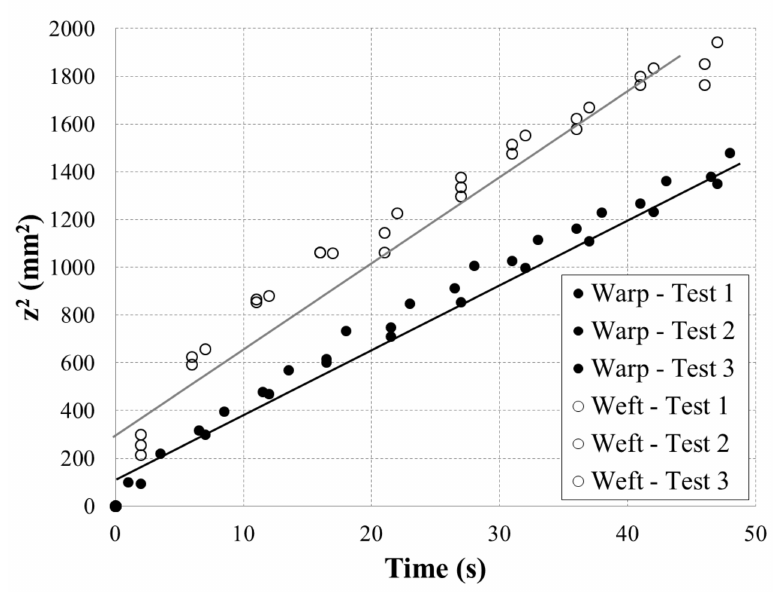
Figure 7. Evolution of the squared height during capillary rise experiments and linear interpolation based on the Lucas-Washburn model.